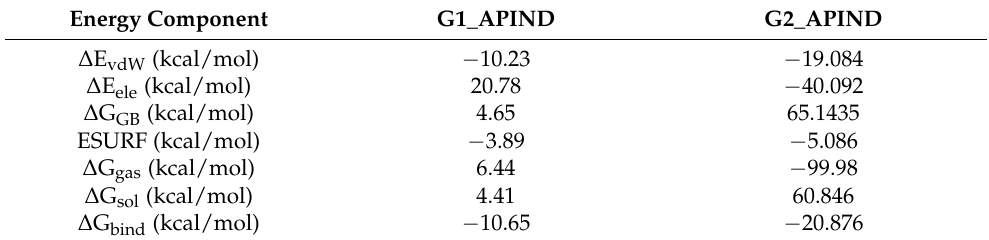
Table 2. Thermodynamic calculations of G1 and G2 variants upon APIND binding.